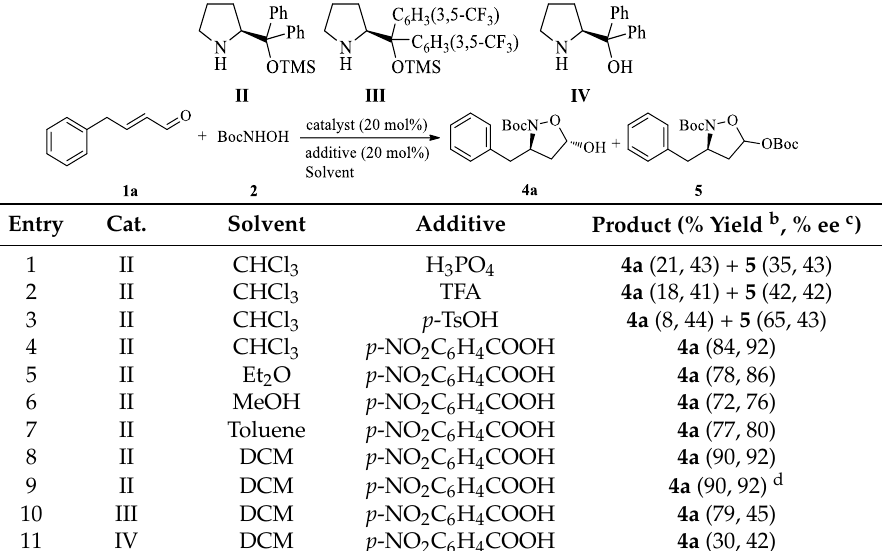
Molecules 2018 , 23 , x FOR PEER REVIEW Table 1. Tandem aza-Michael/hemiacetal reaction between ( E )-4-phenylbut-2-enal 1a and N -Boc-hydroxylamine at the presence of secondary amine and Brønsted acid additives a .